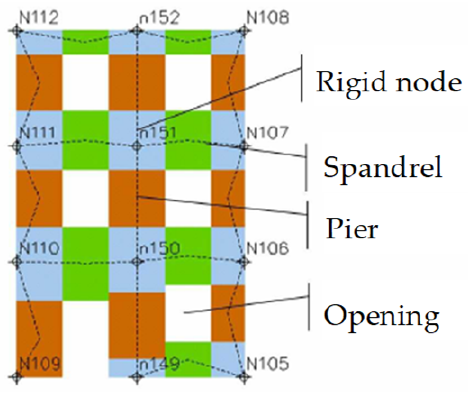
Figure 7. Schematization of a masonry wall in macro-elements with the TreMuri software.